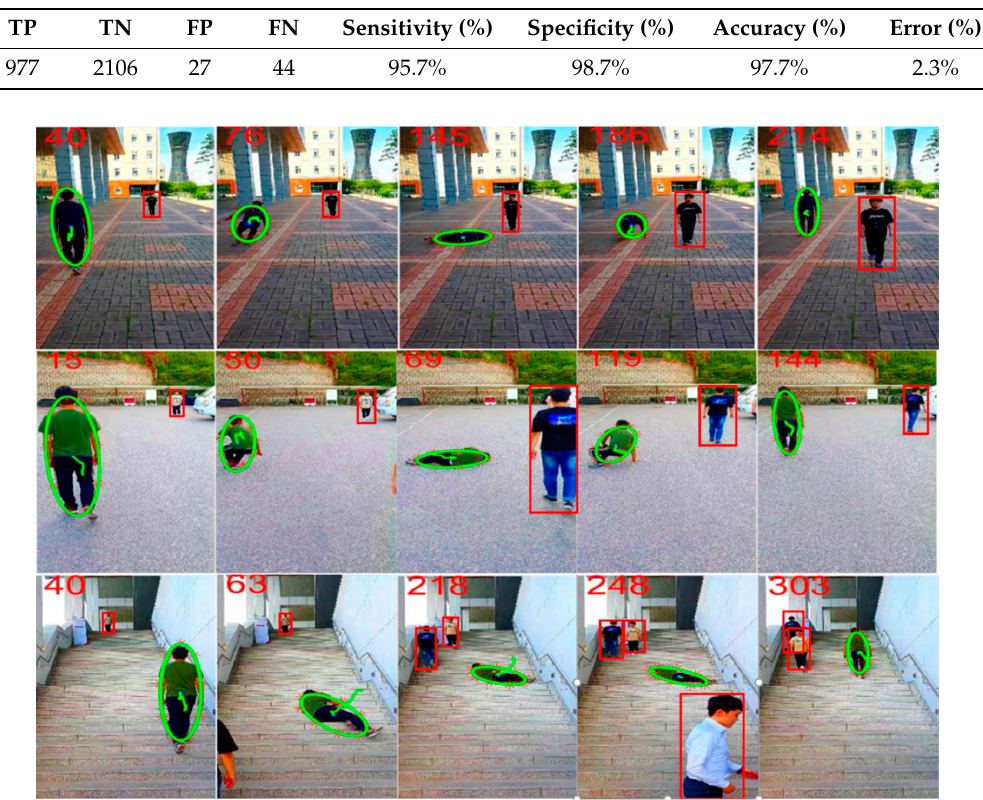
Figure 18. Results of tracking and fall detection in the presence of multiple other people (two to four from the top) in a scene. A person in a green ellipse is a target for tracking and fall detection. Table 3. Classification result of our system for all experiments.